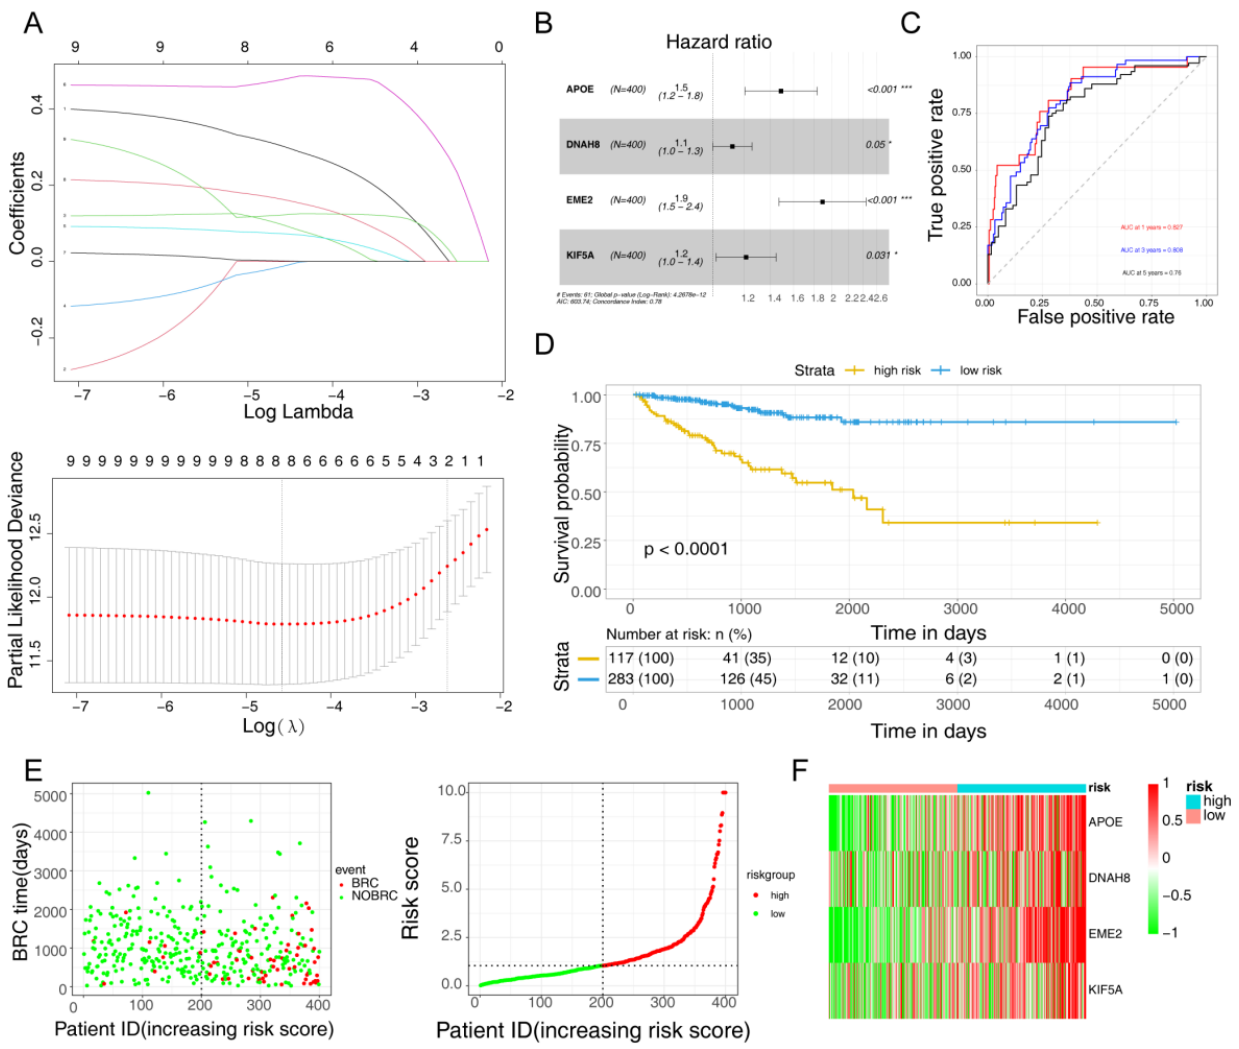
Figure 2. Evaluation of the risk model with risk score in the TCGA dataset. ( A ) LASSO regression analysis. ( B ) Multivariate Cox analysis of model genes. * p < 0.05, *** p < 0.001. ( C ) ROC analysis of the prognostic risk score model. ( D ) K – M analysis of the prognostic risk score model. ( E ) Scatter plot for BCR and distribution of risk score in the TCGA dataset. ( F ) Heatmap of model genes expression in the TCGA dataset.